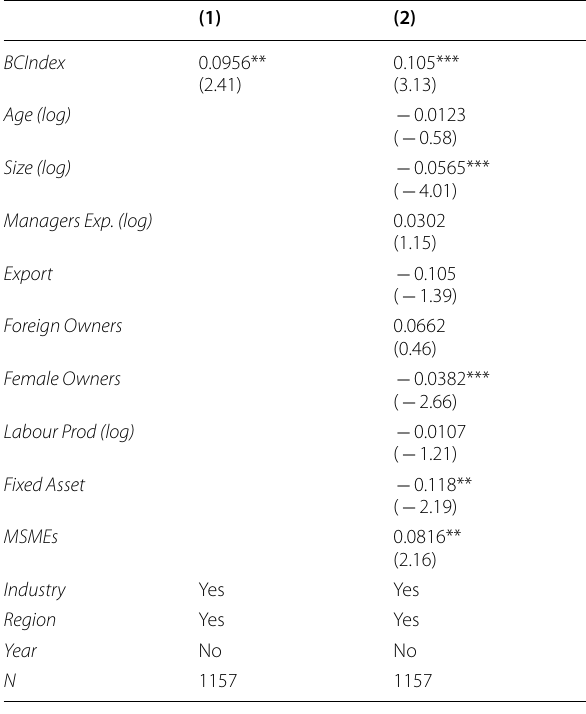
Table 4 Probit regression estimates: average marginal effects. Dependent Variable: Firm